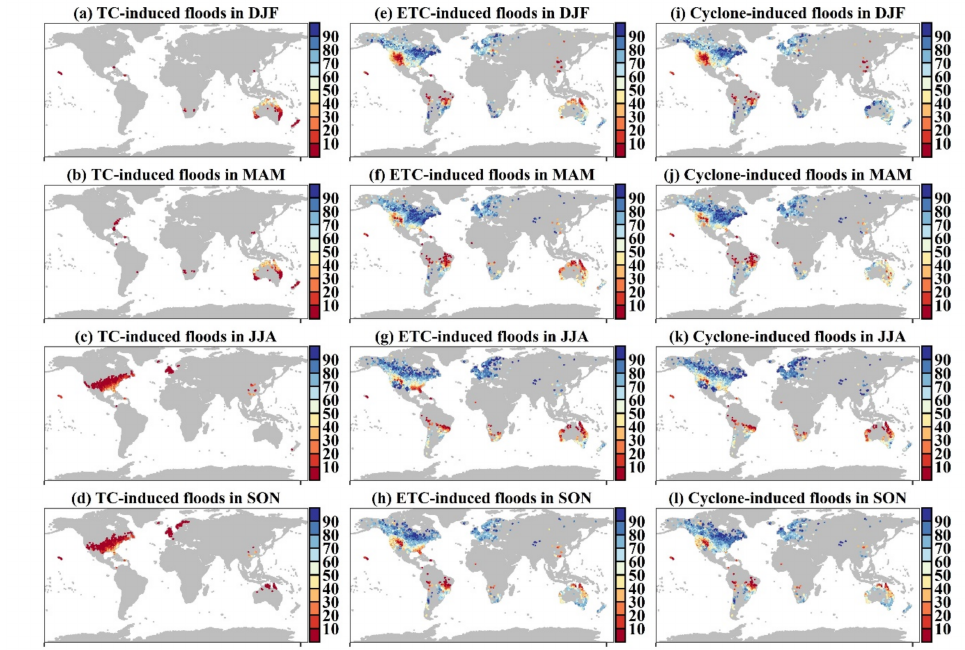
Figure 5. Contributions (%) of tropical cyclones (TCs, a – d ), extratropical cyclones (ETCs, e – h ), and all cyclones ( i – l ) to seasonal floods in observations sampled by peak-over-threshold (POT) method. The four seasons are DJF (December– February), MAM (March–May), JJA (June–August), and SON